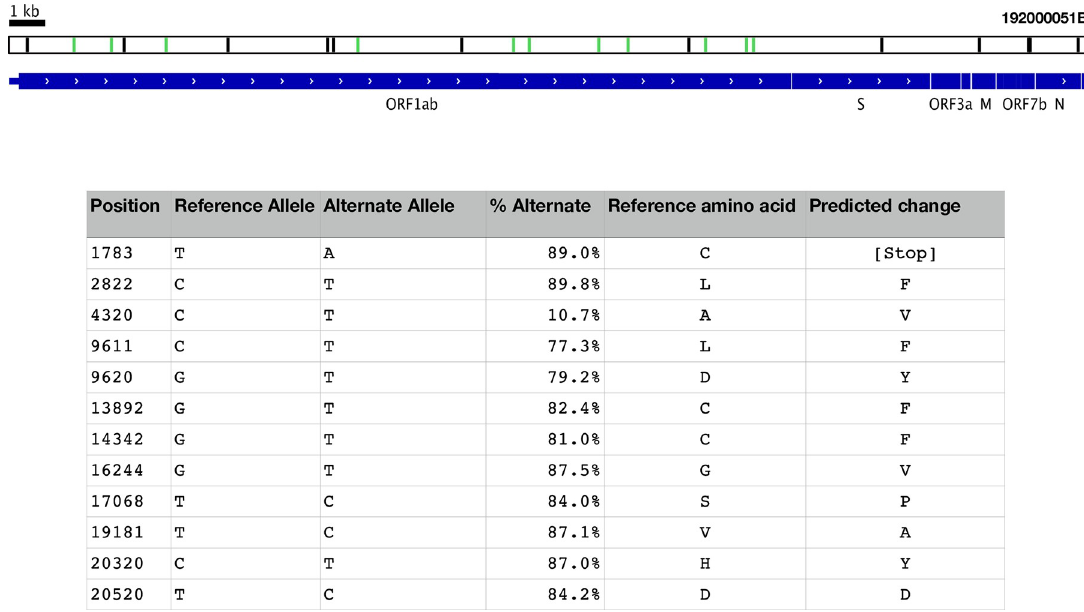
Fig 4. Schematic representation of 192000051B assembly. Black bars represent loci where the assembly called alleles different from the NCBI reference sequence NC_045512. Green bars represent mixed loci where both reference and alternative alleles were called. All mixed loci are in the ORF1ab gene, and are listed in the table, along with the frequency of the alternate allele at the position, and the predicted effect in translation.